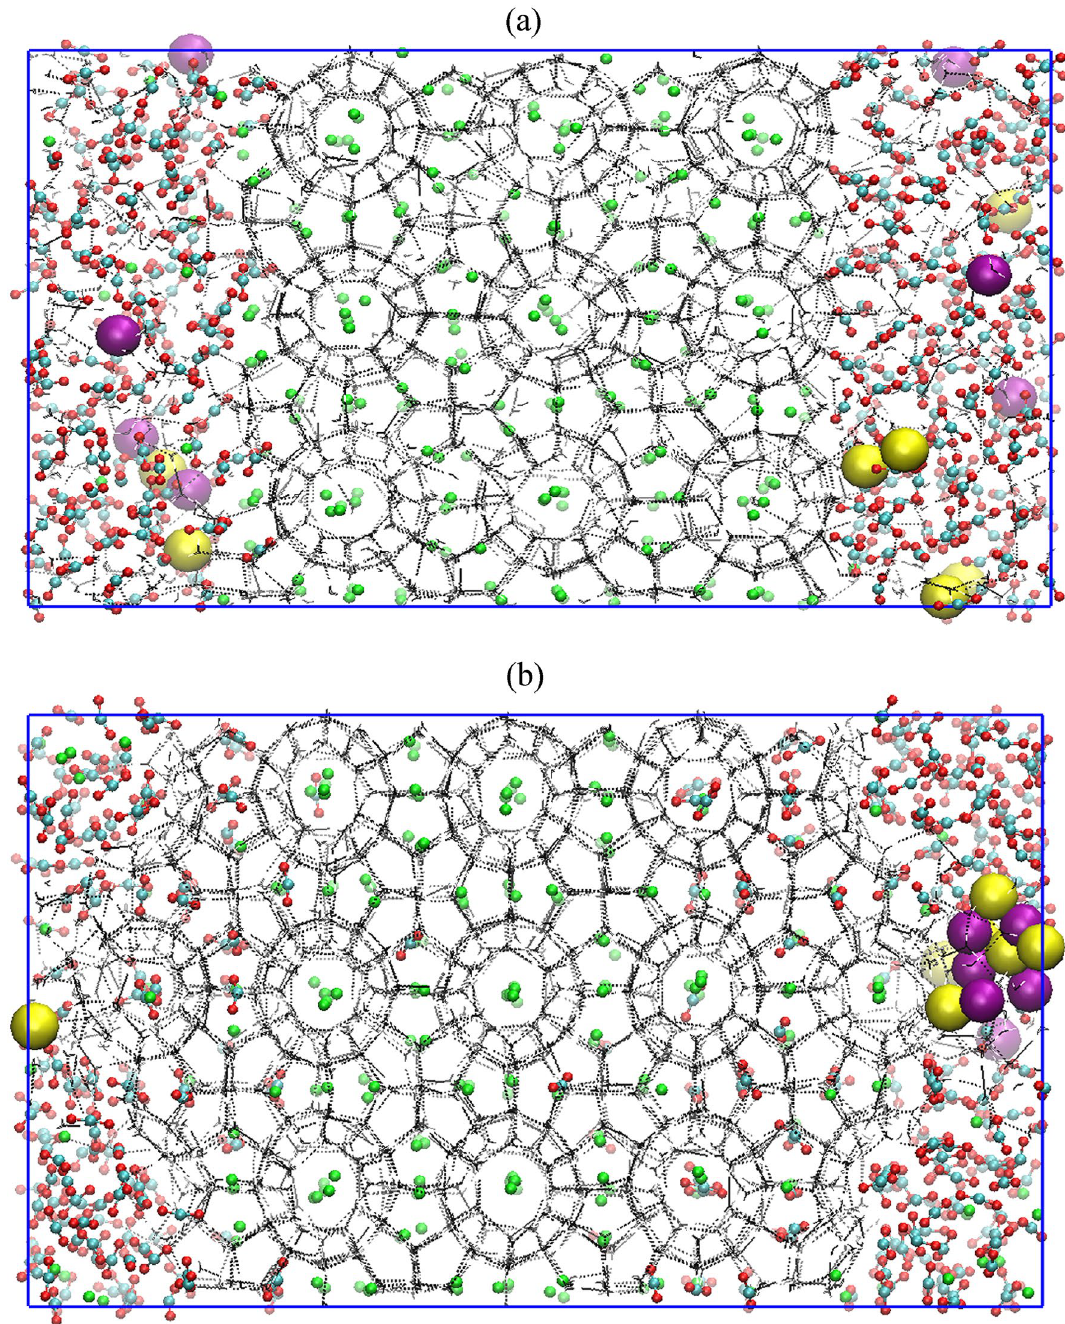
Figure 10. Screenshot of the CH 4 –CO 2 replacement dynamics in presence of free water molecules, carbon dioxide and salt ions with operating conditions of 260 K and 10 MPa at ( a ) 0 µs and ( b ) 2 µs. The atoms of sodium and chlorine ions are represented by purple and yellow spheres,